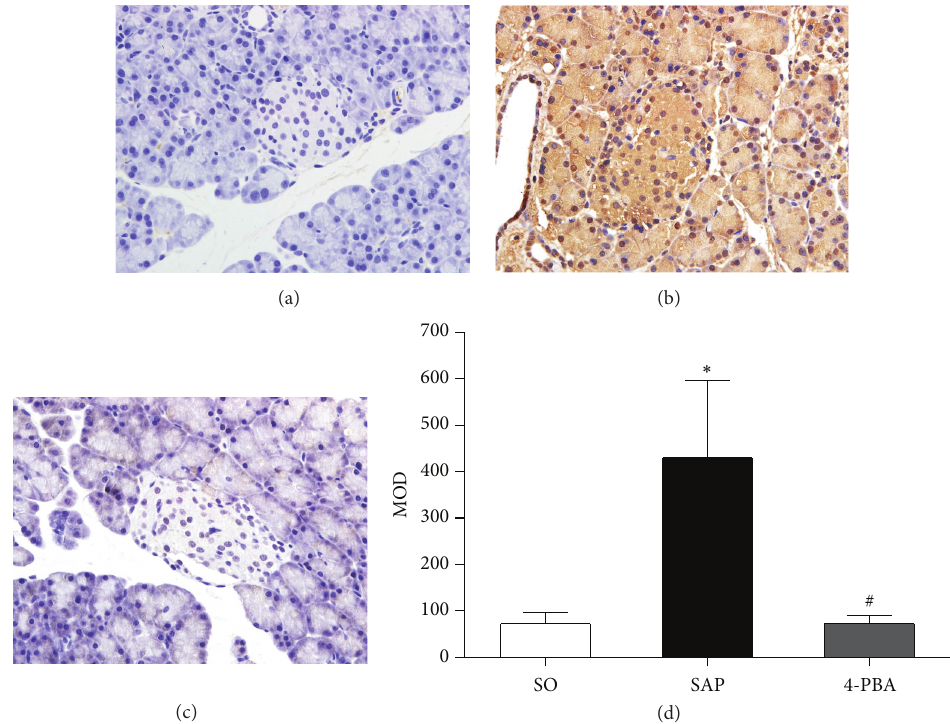
Figure 8: Immunohistochemical expression of CHOP in pancreatic islets (original magnification, × 400). (a) SO group; (b) SAP group; (c) 4-PBA group. (d) Comparison of MOD of CHOP in all groups. Each value represents the mean ± standard deviation. ∗ 𝑃 < 0.05 versus SO group; # 𝑃 < 0.05 versus SAP